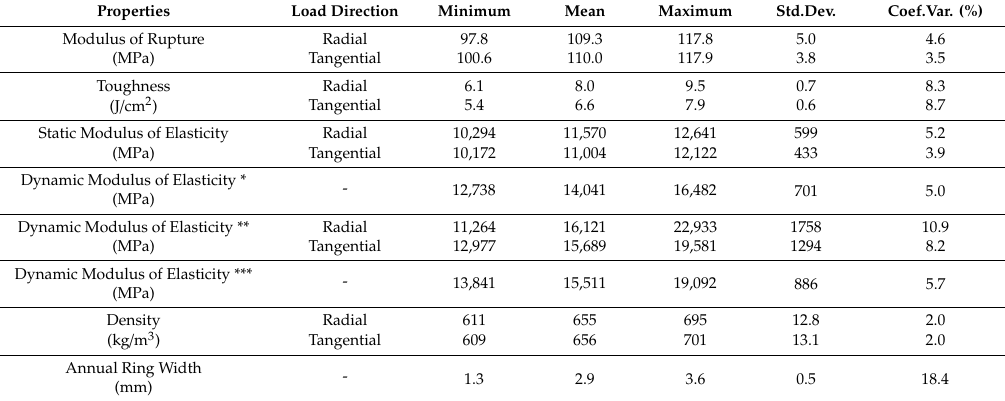
Table 7. Basic Statistical Analyses of the Properties for Ash Wood.